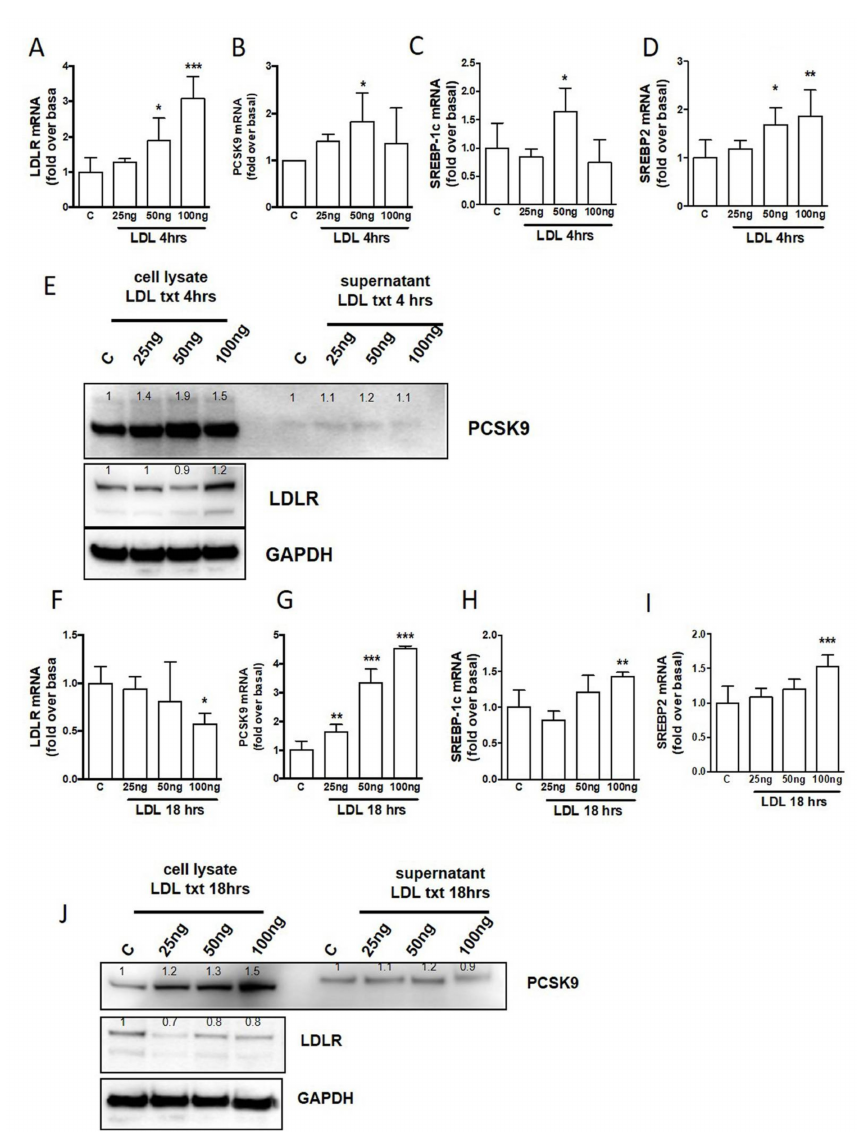
Figure 4. One-way ANOVA. ( A ) Effects of LDL treatment for 4 h on LDLR in differentiated human adipocytes. ( B ) Effects of LDL treatment for 4 h on PCSK9 in differentiated human adipocytes. ( C ) Effects of LDL treatment for 4 h on SREBP-1c in differentiated human adipocytes. ( D ) Effects of LDL treatment for 4 h on SREBP-2 in differentiated human adipocytes. ( E ) PCSK9, LDLR, and GAPDH proteins levels after LDL treatment for 4 h. ( F ) Effects of LDL treatment for 18 h on LDLR in differentiated human adipocytes. ( G ) Effects of LDL treatment for 18 h on PCSK9 in differentiated human adipocytes. ( H ) Effects of LDL treatment for 18 h on SREBP-1c in differentiated human adipocytes. ( I ) Effects of LDL treatment for 18 h on SREBP-2 in differentiated human adipocytes. ( J ) PCSK9, LDLR, and GAPDH proteins levels after LDL treatment for 18 h. * p < 0.05, ** p < 0.01 and *** p < 0.001 vs.